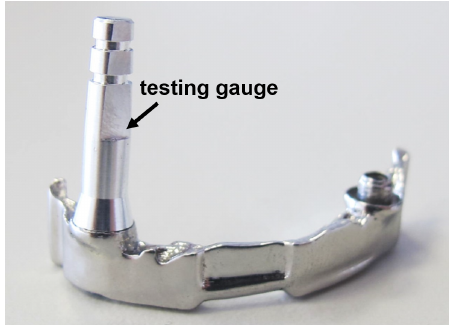
Figure 7. Dental framework with testing